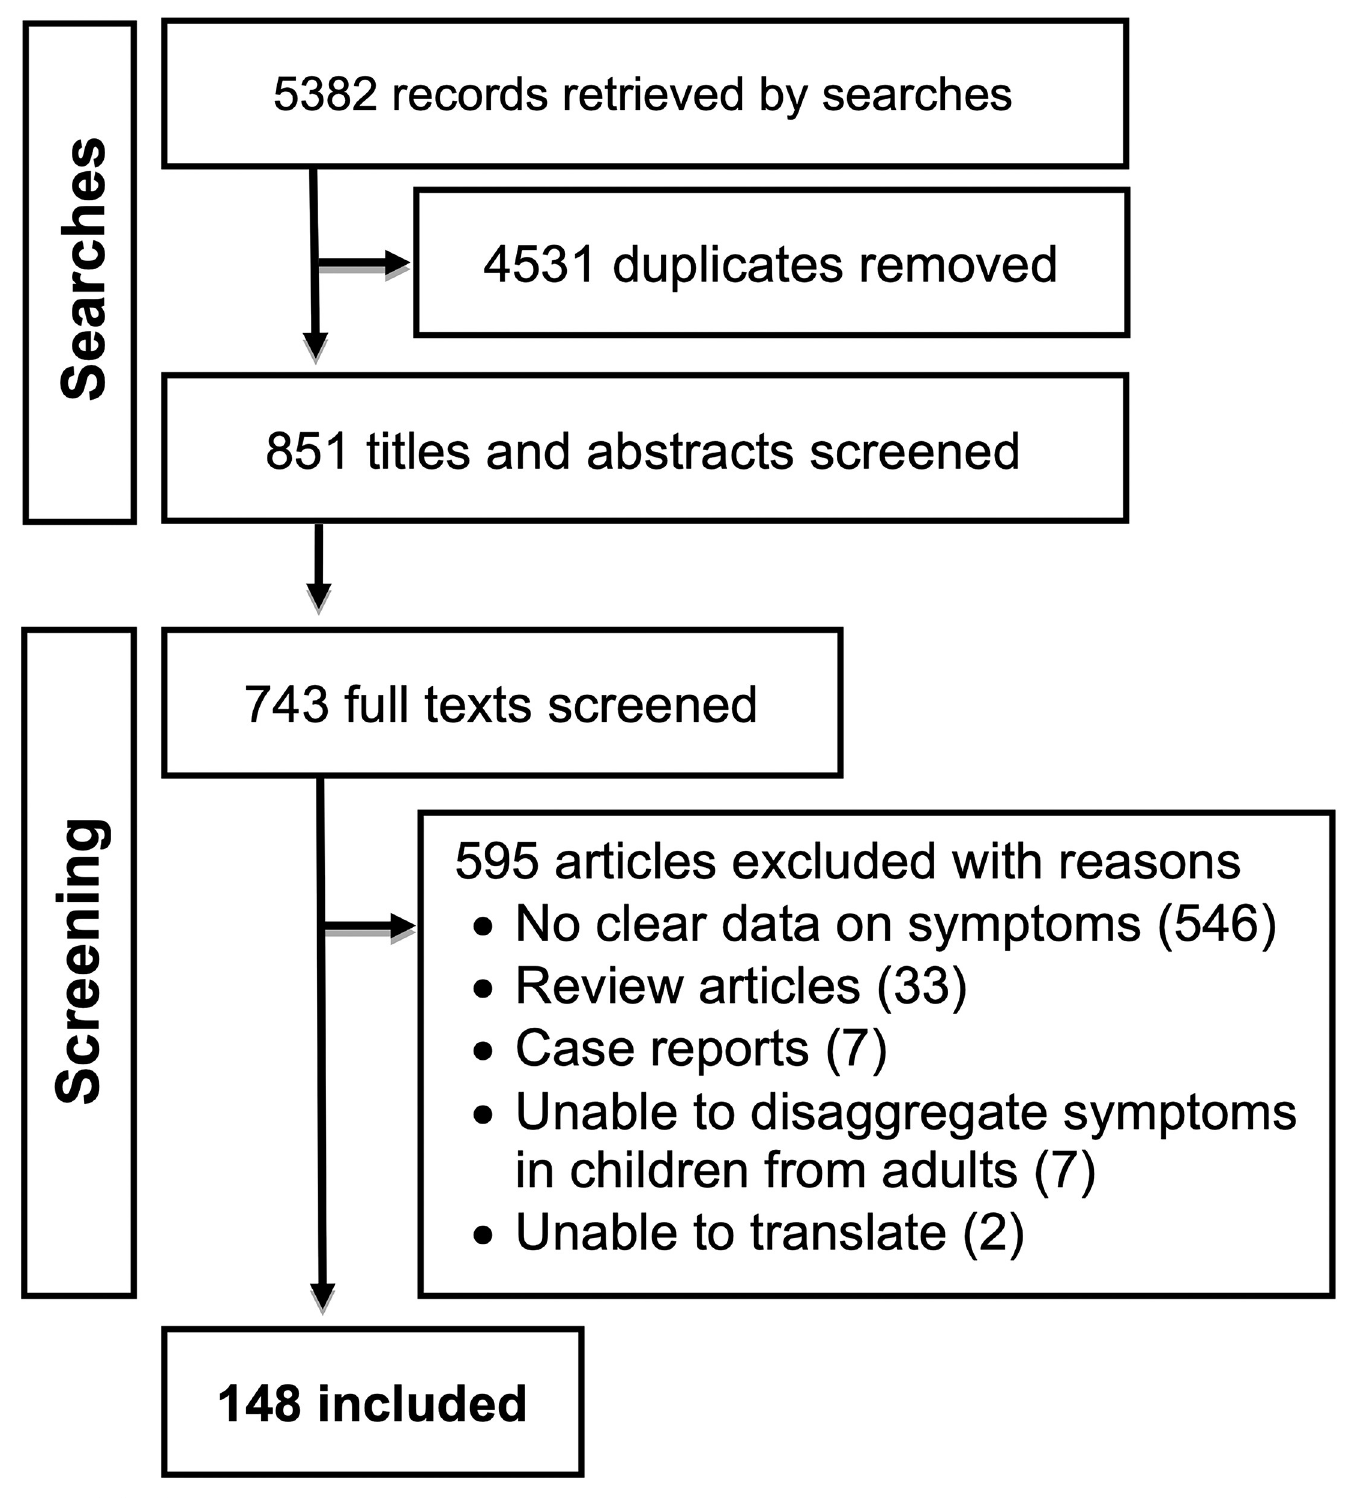
Fig 1. Study flow chart.